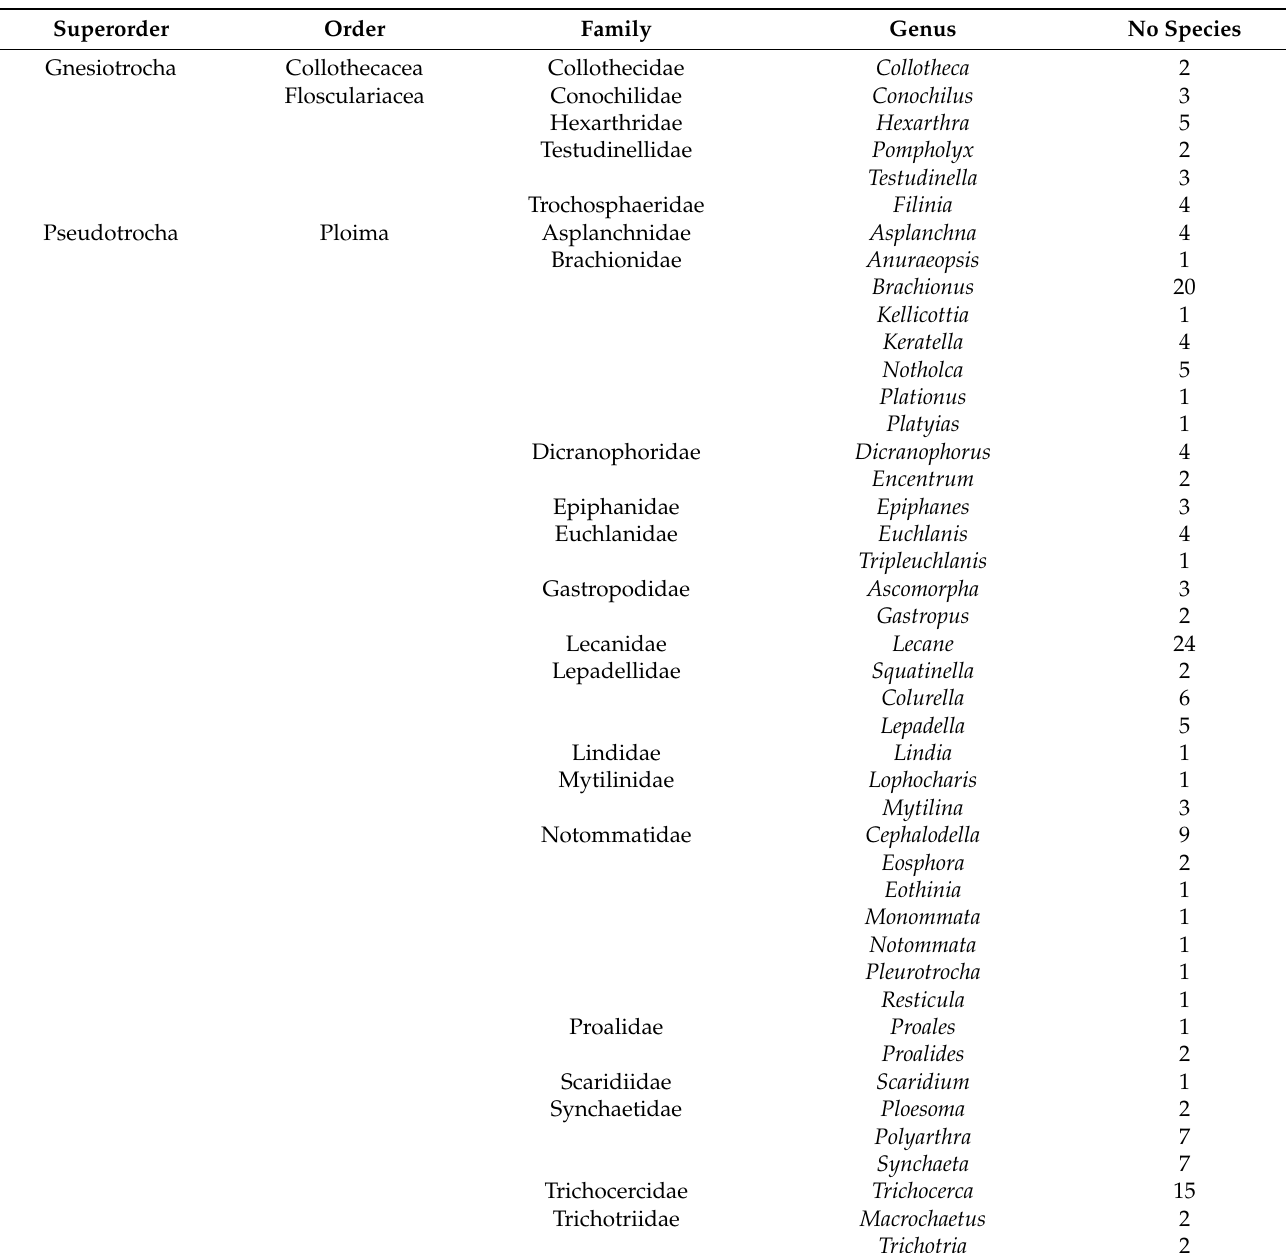
Table 2. Number of species per